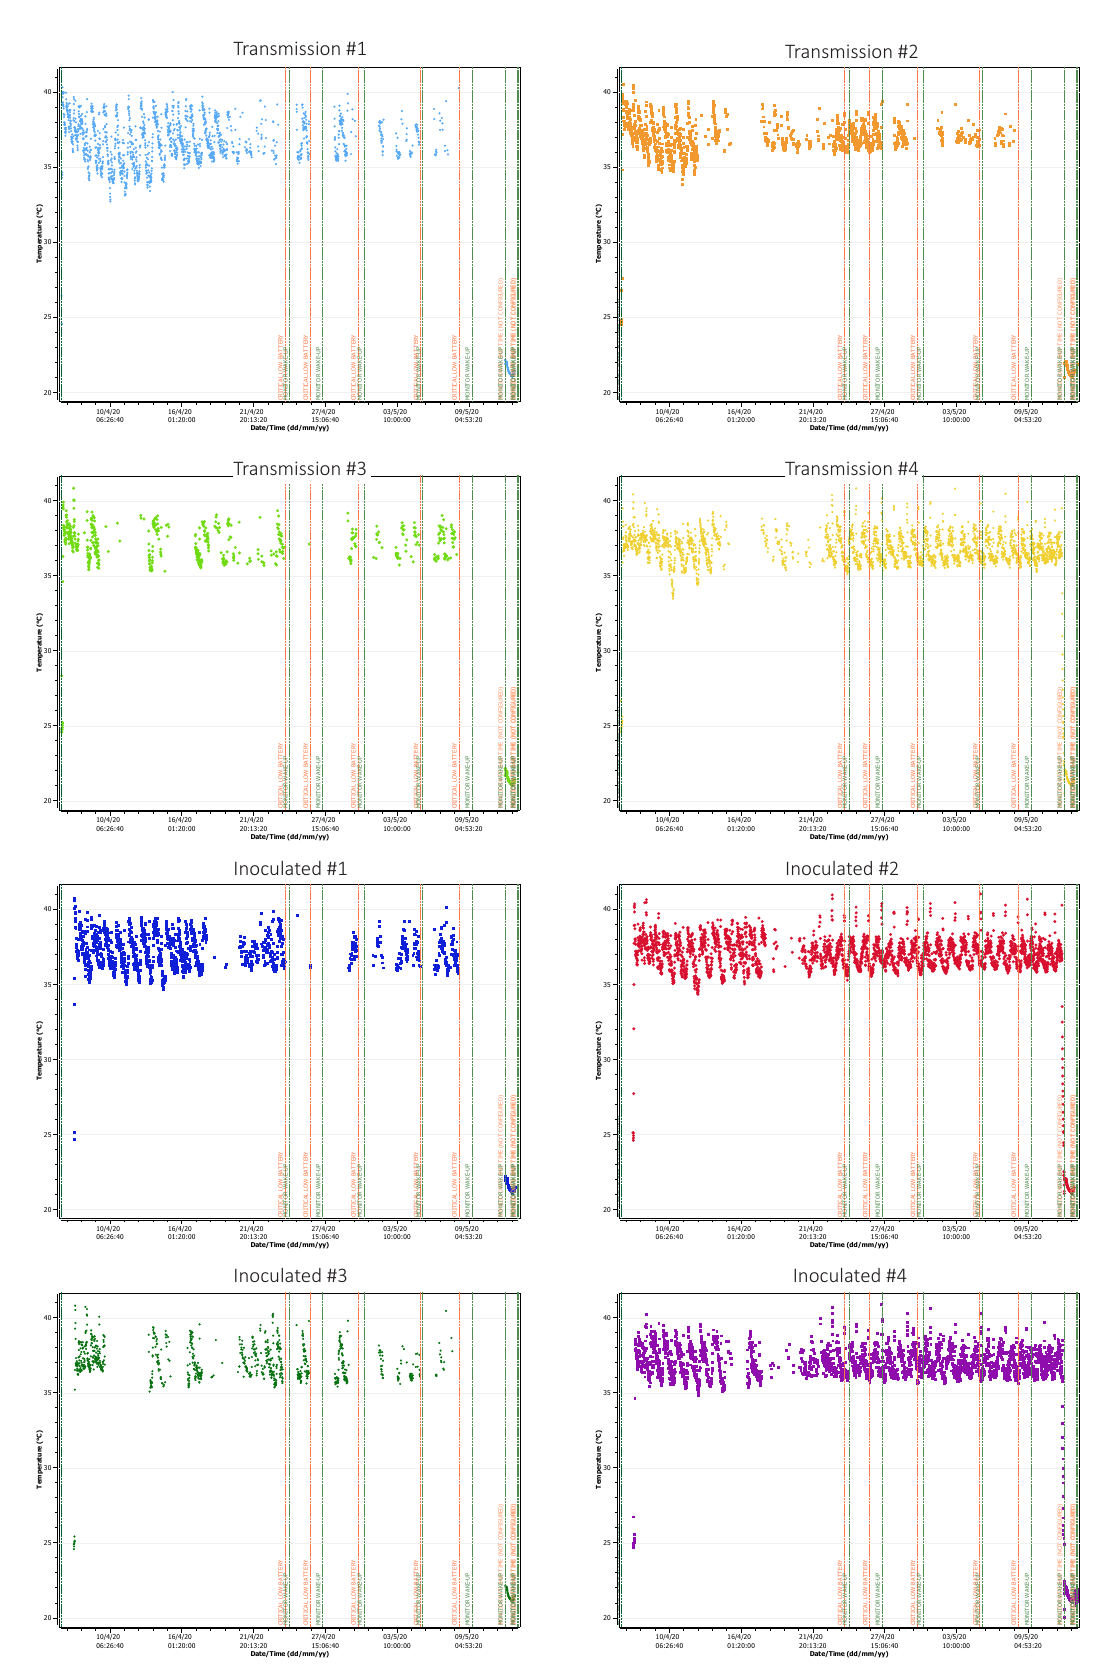
Figure 3. Temperature data of four infected and four contact animals. Body core temperatures were recorded every 15 min, some of the signals were lost due to the experimental setup (metal cages interfere with signal transduction to the monitor). Blue vertical line indicates challenge; red horizontal line shows 41 ◦